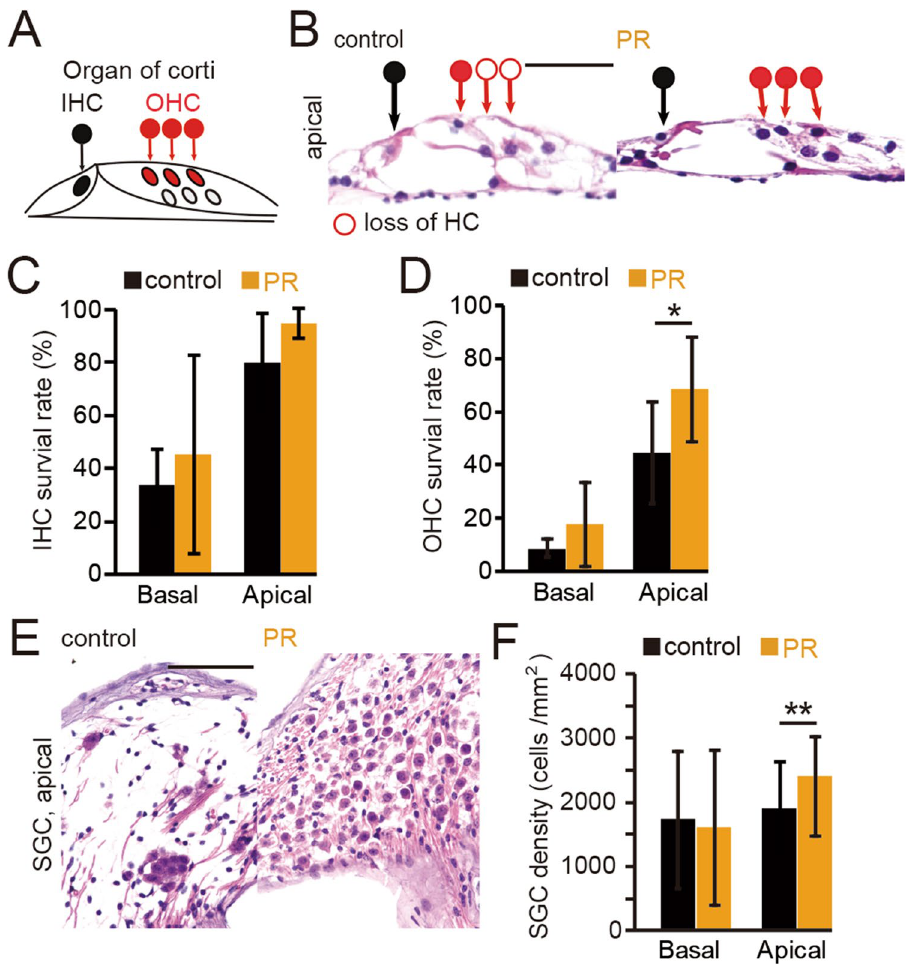
Figure 2. Effects of 10 months of PR on age-related degenerative changes in the inner ear. ( A ) Schematic diagram of the organ of Corti. The closed black circle indicates a surviving inner hair cell (IHC), and the closed red circle indicates a surviving outer hair cell (OHC). ( B ) Hematoxylin and eosin-stained images at the apical turn of the organ of Corti in control and PR mice. The open circle represents the loss of hair cells. Scale bar 50 μm. ( C ) Survival rates of IHCs in control and PR mice. At basal and apical turns, no significant differences in IHCs were found between PR and control mice (Mann–Whitney test). ( D ) Survival rates of OHCs in control and PR mice. The OHC survival rate in the PR mice was significantly higher than that in the controls only at the apical turn (*P < 0.05, Mann–Whitney test). ( E ) Representative images of spiral ganglion cells (SGCs) at the apical turn in control and PR mice. Scale 50 μm. ( F ) Summary of the SGC density at the basal and apical turns. Significantly higher averaged SGC density in the PR mice compared with the controls was observed only at the apical turn (**P < 0.01, Mann–Whitney